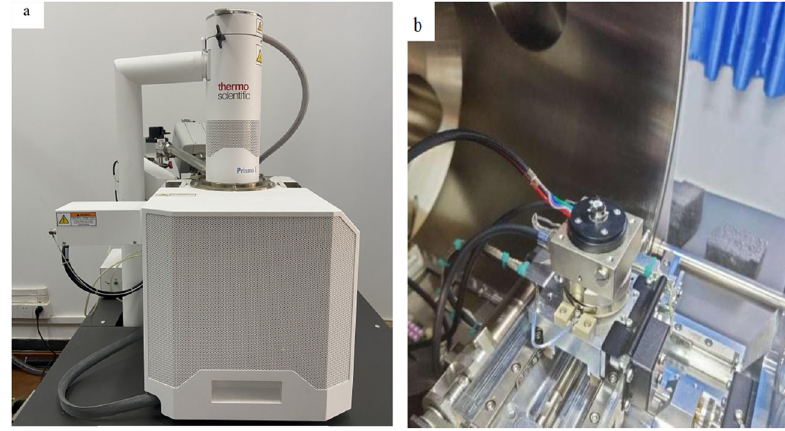
Figure 5: SEM. ( a ) Instrument appearance. ( b ) Carrier